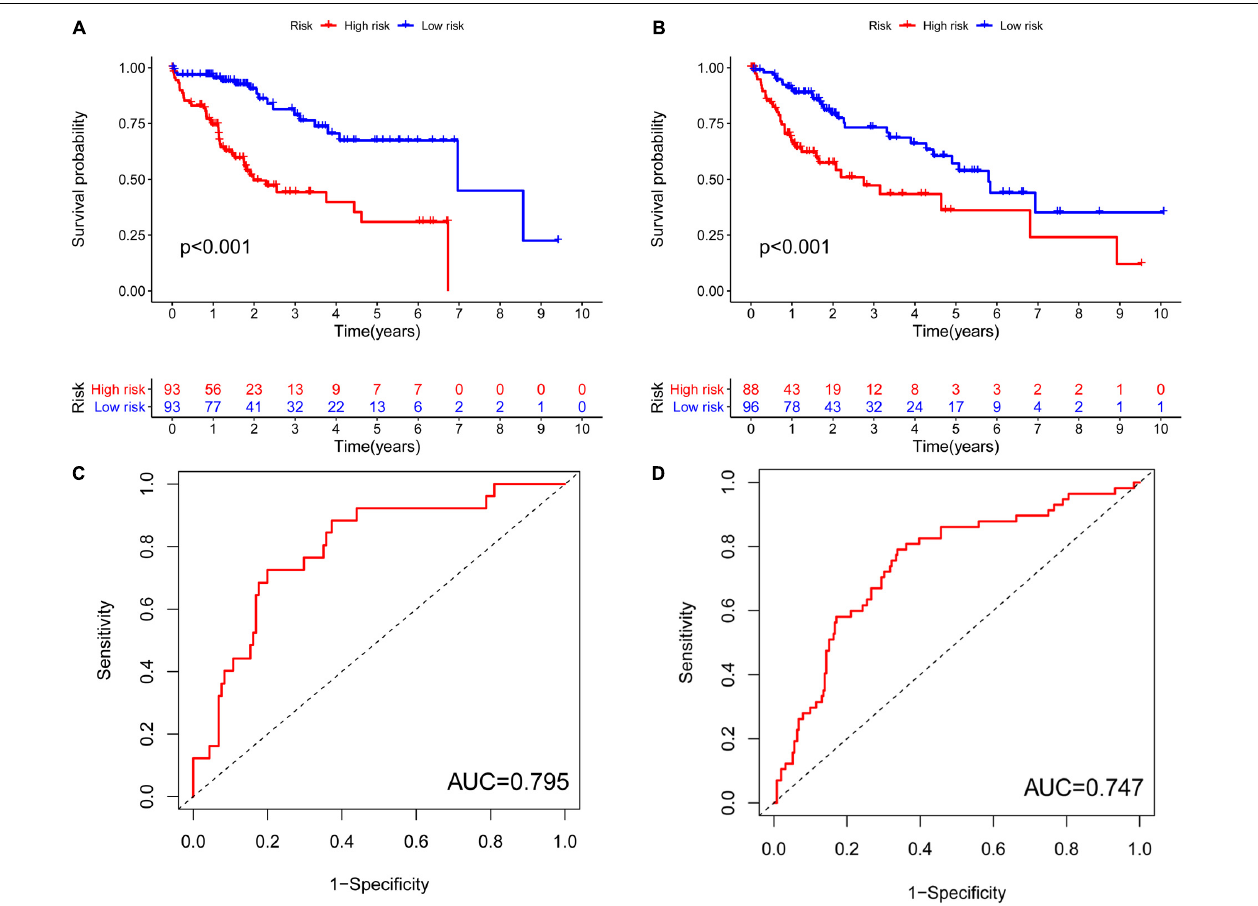
FIGURE 5 | Characteristics of the pyroptosis-related lncRNA signature in the training set and testing cohort. (A) Kaplan–Meier analysis indicated that high-risk patients had poorer survival compared with the low-risk group in the training cohort. (B) Kaplan–Meier analysis indicated that high-risk patients had poorer survival compared with the low-risk group in the testing cohort. (C) ROC curves to determine whether the expression pattern of lncRNAs related to survival can be used as an early predictor of HCC and an AUC of 0.795 in the training set. (D) An AUC 0.747 in the testing set. AUC, area under curve.